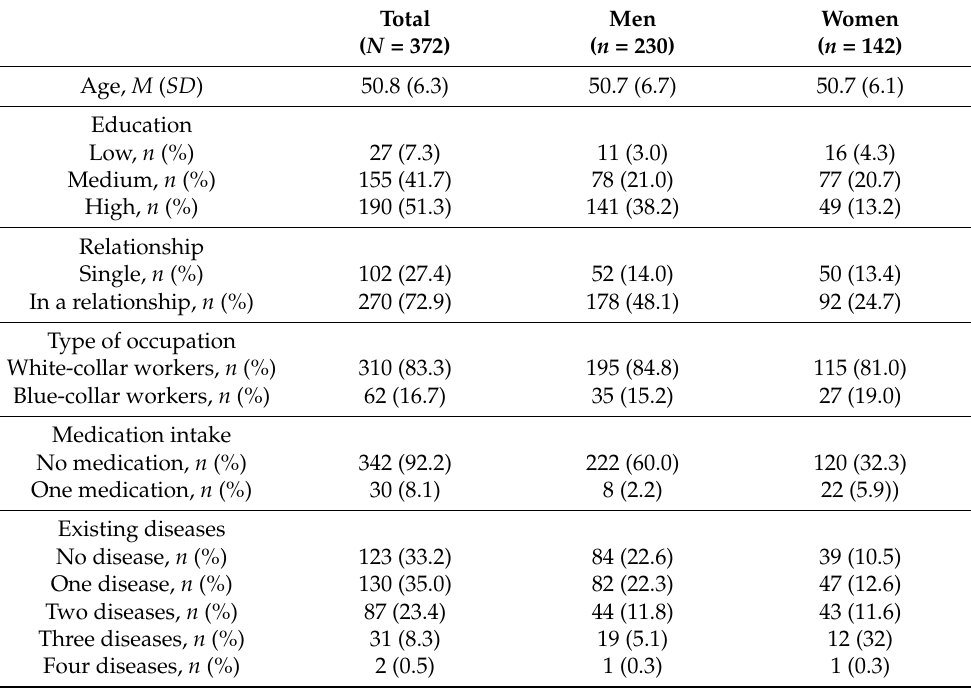
Table 1. Baseline characteristics of the study